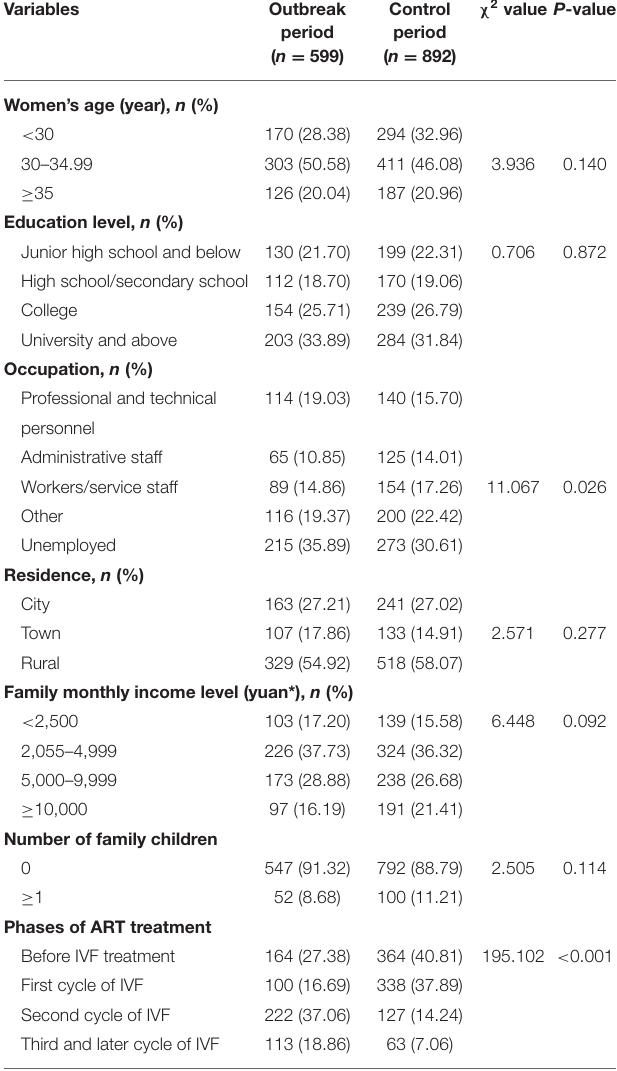
TABLE 1 | Baseline characteristics of the study subjects